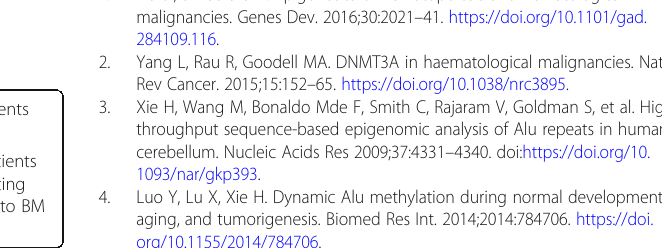
Additional file 3: Table S3. Molecular characteristics of the CMML patients retrospectively analyzed in this study. (DOCX 12